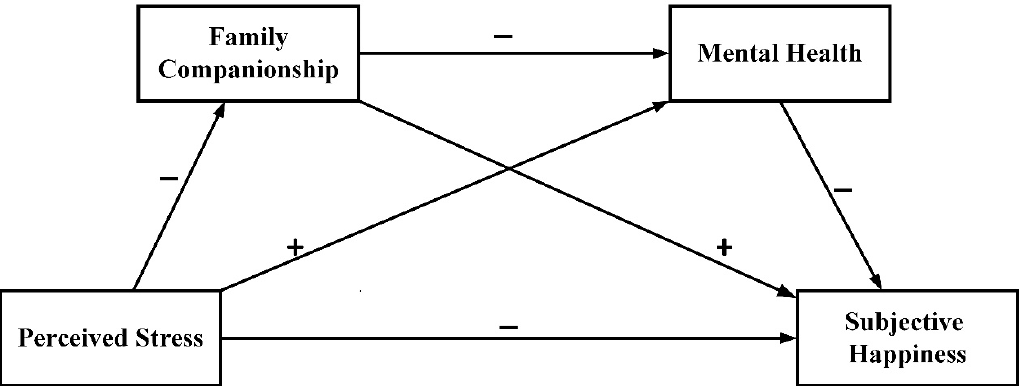
Figure 1. Hypothesized model of perceived stress, family companionship, mental health, and subjective happiness.